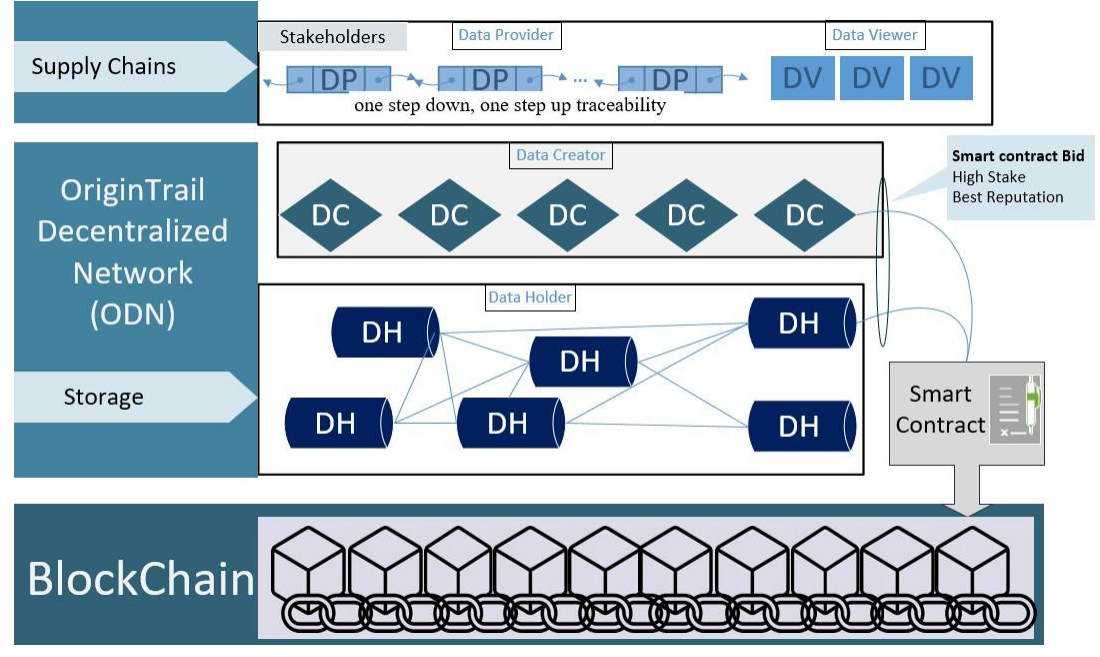
Figure 3. OriginTrail